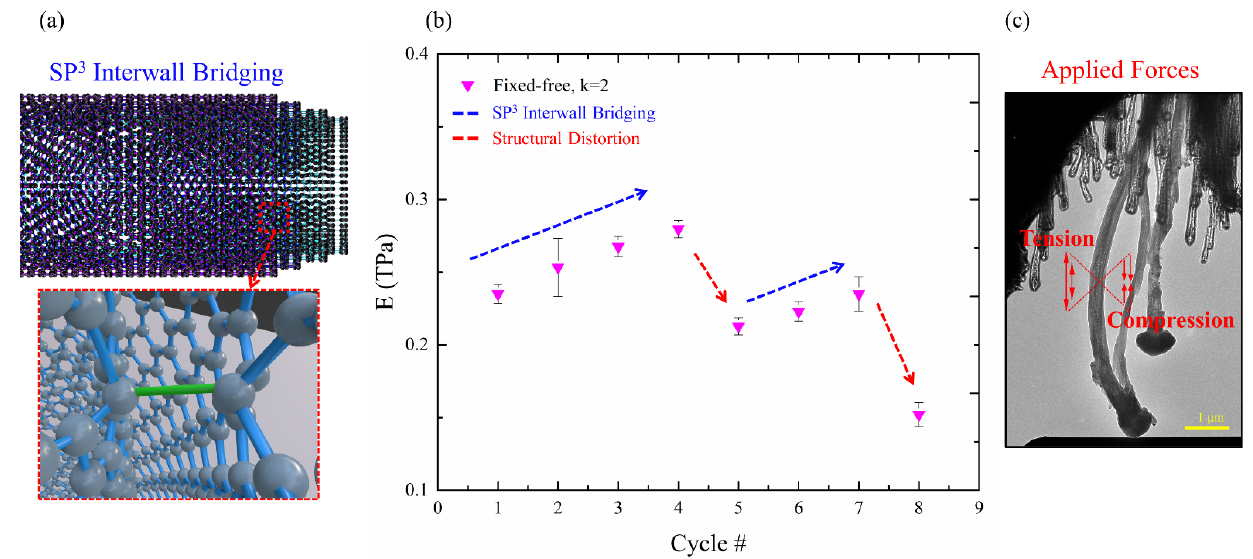
Figure 5. ( a ) Illustration of MWCNT with interwall sp 3 bonding and local distortion in the CNT structure. ( b ) Young’s modulus values per cycle, calculated via Euler’s column formula. The results reveal two competing effects which influenced the tube’s stiffness—interwall sp 3 bridging (blue arrows) and structural distortion (red arrows). The mechanical stiffening may be explained by the creation of interwall sp 3 bonding via electron irradiation which strengthens the bonding of interior walls. The decrease in modulus is attributed to structural distortion caused by the out-of-plane and weaker sp 3 hybridization deforming the layers themselves, making them more susceptible to plastic deformation at higher stresses. ( c ) The bent nanotube underwent repeatable tensile and compressive forces, marked by the arrows, which in time distorted its inner structure and reduced its stiffness.